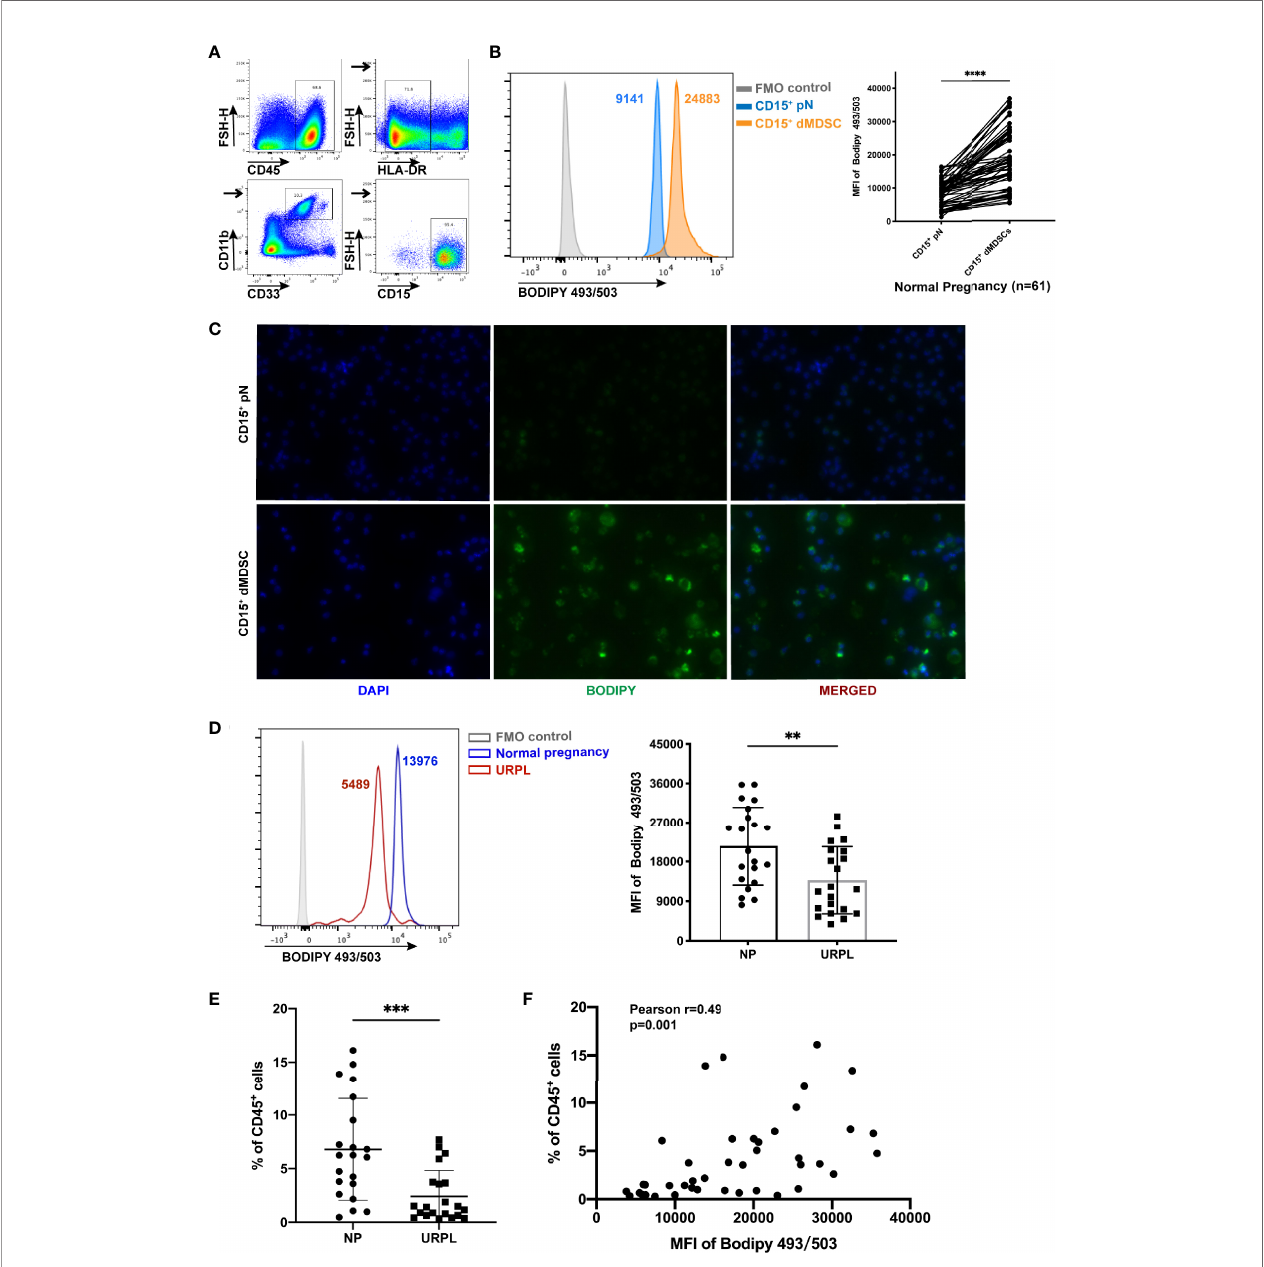
FIGURE 1 | Increased lipid accumulation in decidual polymorphonuclear myeloid-derived suppressor cells (PMN-MDSCs). (A) Flow cytometry showing the gating strategy for PMN-MDSCs (gated on CD45+HLA-DR-/lowCD11B+CD33dimCD15+CD14-). (B) Lipid accumulation of CD15+ decidual MDSCs (dMDSCs) and autologous peripheral neutrophils (pN) (n = 61) in normal pregnancy (NP). (C) Immuno fl uorescence images of BODIPY 493/503 (green) in CD15+ dMDSCs and autologous pN. (D) Lipid accumulation in CD15+ dMDSCs in NP (n = 21) and URPL (n = 21) patients. (E) The proportion of CD15+ dMDSCs was compared between NP (n = 21) and unexplained recurrent spontaneous abortion (URPL) (n = 21). (F) The correlation of lipid accumulation in CD15+ dMDSCs with the proportion of CD15+ dMDSCs within a population of CD45+ leukocytes (n = 42). All data are represented as mean ± SD. Signi fi cance was determined by paired or unpaired Student ’ s t-test. ****p < 0.0001, ***p < 0.001, **p < 0.01. FMO, fl uorescent minus